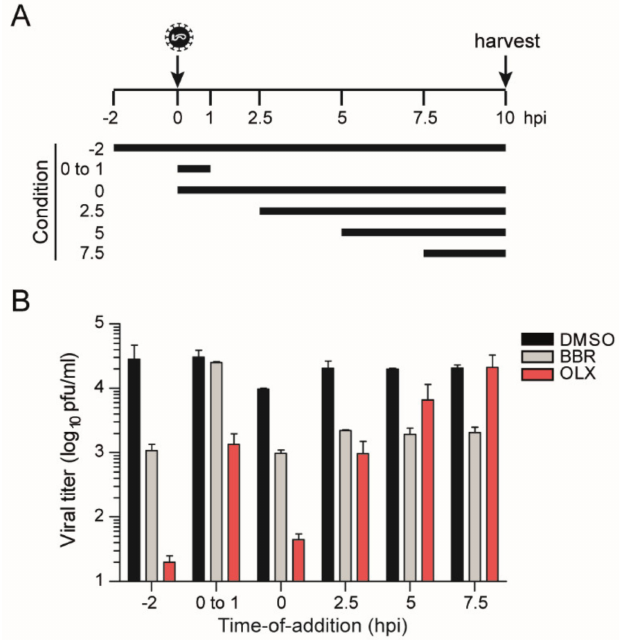
Figure 3. Time-of-addition assay. Vero E6 cells were infected with SARS-CoV-2 (BavPat1 isolate) at an MOI of 1. ( A ) Schematic layout of the assay. 20 µ M berberine (BBR), 0.25 µ M obatoclax (OLX), or 0.1% DMSO as a control was added to the infected cells at the indicated time points. ( B ) Plaque assay titers from cell culture supernatants that were collected at 10 hpi. Bars and error bars represent means and SD of n = 2